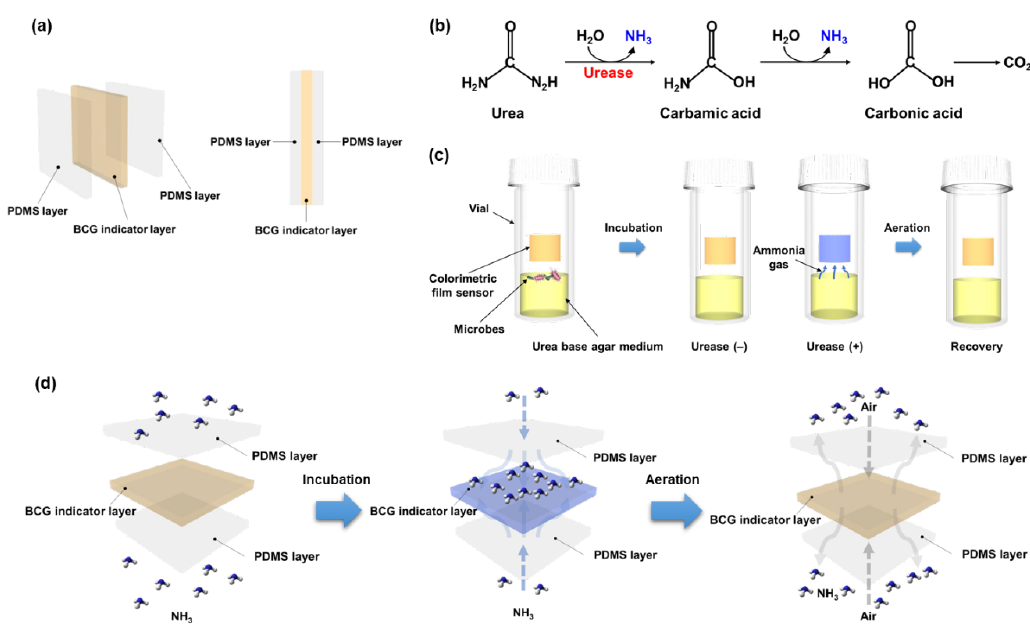
Figure 1. Schematic diagram of the colorimetric detection of microbial urease activity using the designed film sensor. ( a ) Composition of the colorimetric film sensor. ( b ) Reaction mechanism of the enzymatically catalyzed hydrolysis of urea. ( c ) Schematic of the experimental procedure used for the detection of ureolytic bacteria. ( d ) Reversible changes in the color of the sensor upon its exposure to ammonia gas and subsequent aeration.